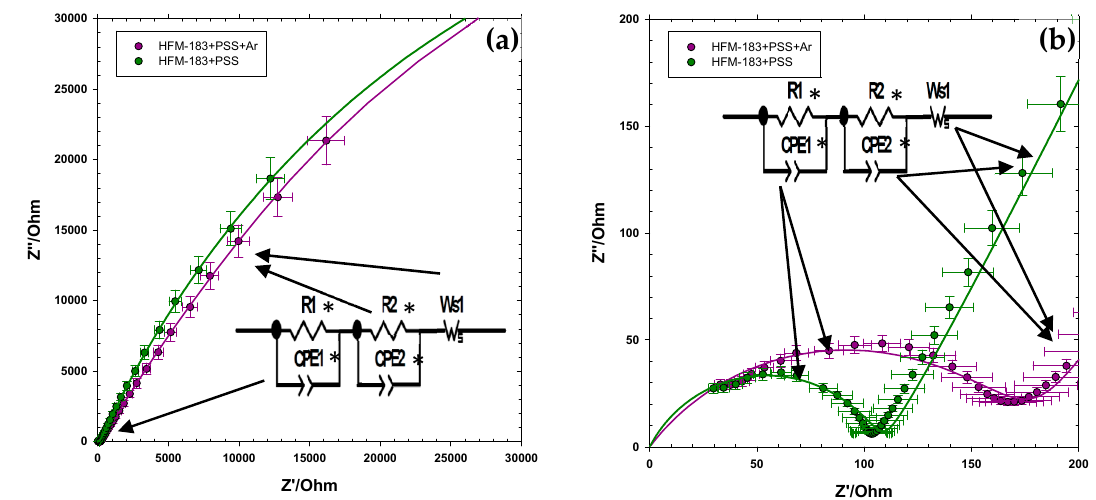
Figure 7. Nyquist plot for the HFM-183+PSS and HFM-183+PSS+Ar membranes and a K 2 CrO 4 concentration of 0.005 mol·L − 1 . Complete plot from 10 MHz to 10 MHz (a) and high frequency zoom (b) .